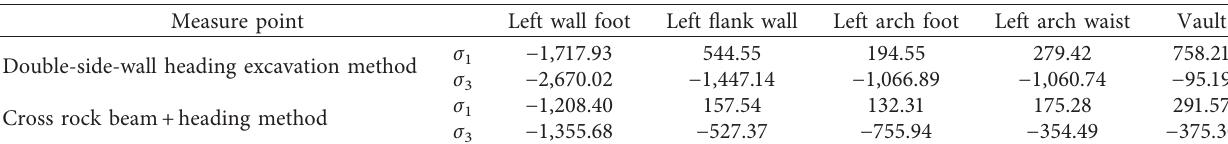
Figure 6: Plastic zone: (a) double-side-wall heading excavation method; (b) cross rock beam +heading method. Table 4: Principal stress of key points